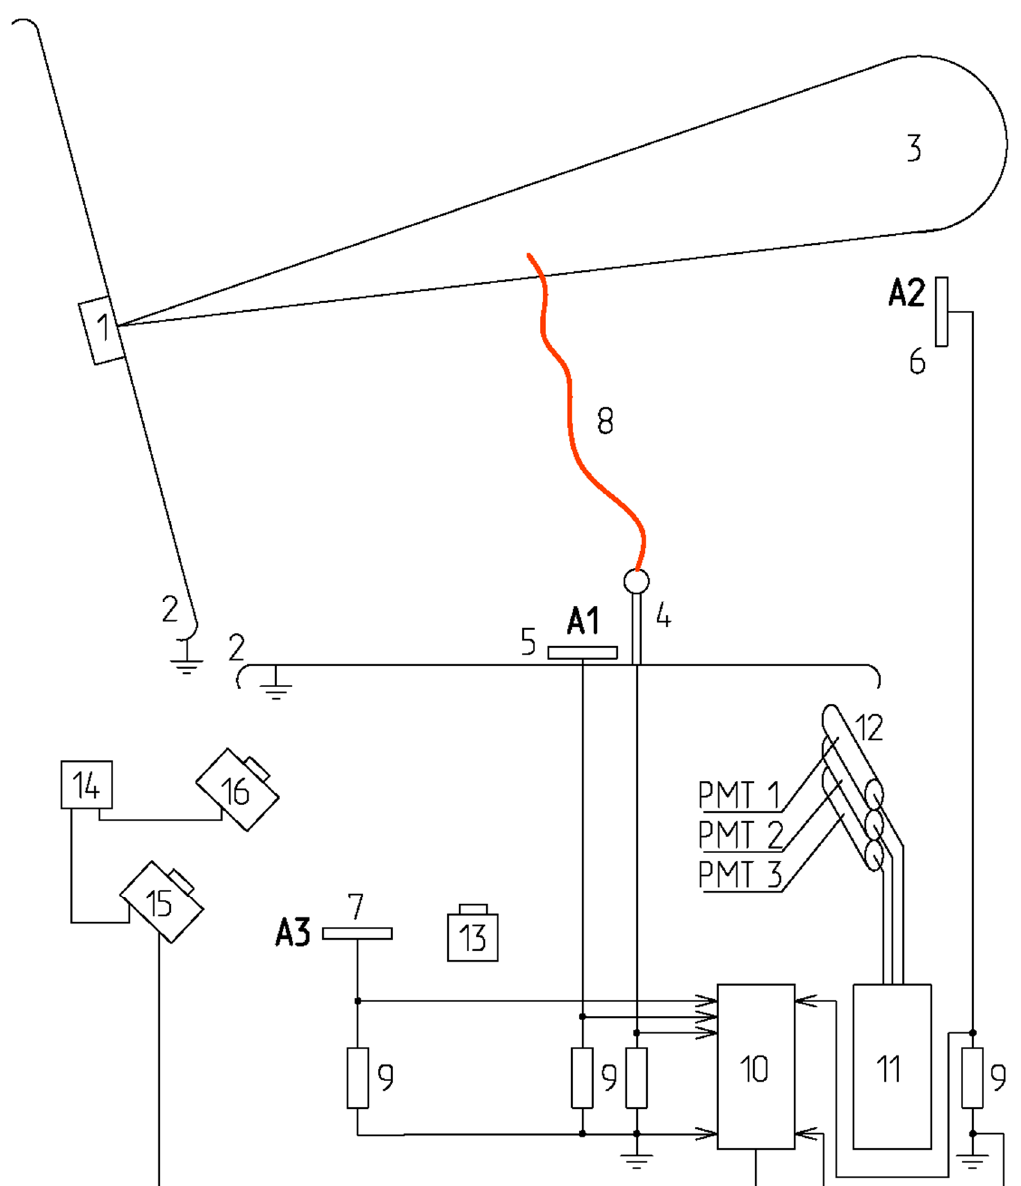
Figure 1. Basic scheme of the experimental measurement complex: 1—charged aerosol generator, 2—grounded electrostatic screens, 3—artificial thunderstorm cell, 4—rod or elongated model electrodes, 5–7—flat antennas, 8—spark discharges, 9—low inductive shunts, 10, 11—digital memory oscillographs, 12—a system of photoelectronic multipliers, 13—digital camera, 14—trigger generator, 15—photoelectron multiplier, 16—electron-optical camera. The radius of the spherical (conical at the small radii of the curvature tip) tip of the model rod electrode varied within the range from 0.05 cm to 3.5 cm. The main experi- mental series were performed for the tip radii of the model rod electrode of 0.9 cm, 1.5